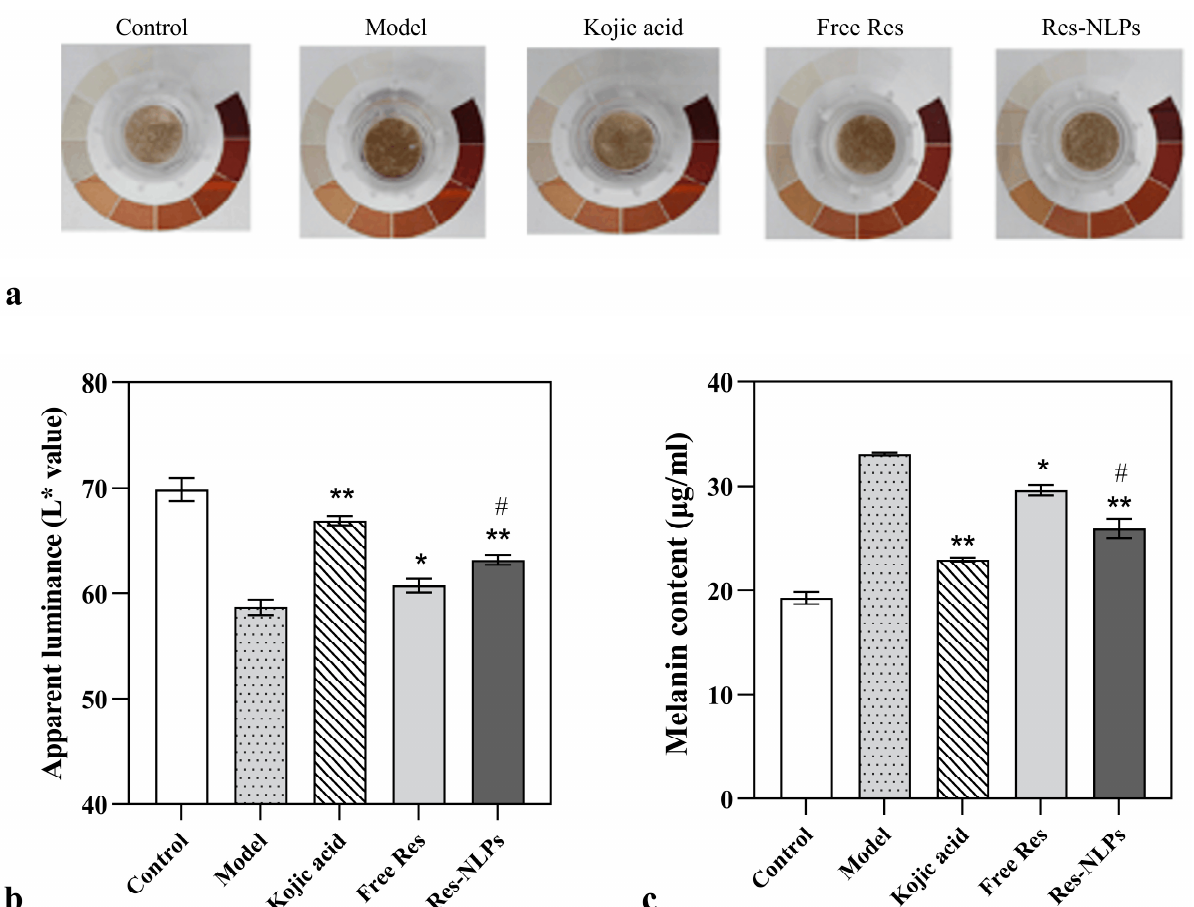
Figure 8. The skin-brightening effect of Res studied using the 3D melanin skin models. ( a ) apparent colorimetric, ( b ) apparent luminance and ( c ) melanin contents of the 3D skin model treated with 20 µ L 500 µ g/mL kojic acid, 300 µ g/mL free Res or Res-NLPs with the same Res concentration as the free Res, respectively. The 3D skin model without treatment served as the control group. The model group, the kojic acid group, the free Res group and the Res-NLPs group were treated with UVB irradiation (50 mJ/cm 2 ) daily, while the control group was not irradiated with UVB and only the culture solution was changed daily. The 3D skin model treated with UVB irradiation only served as the model group. Mean ± SD ( n = 3). * p < 0.05, ** p < 0.01, compared with the model group; # p < 0.05, compared with the free Res group.